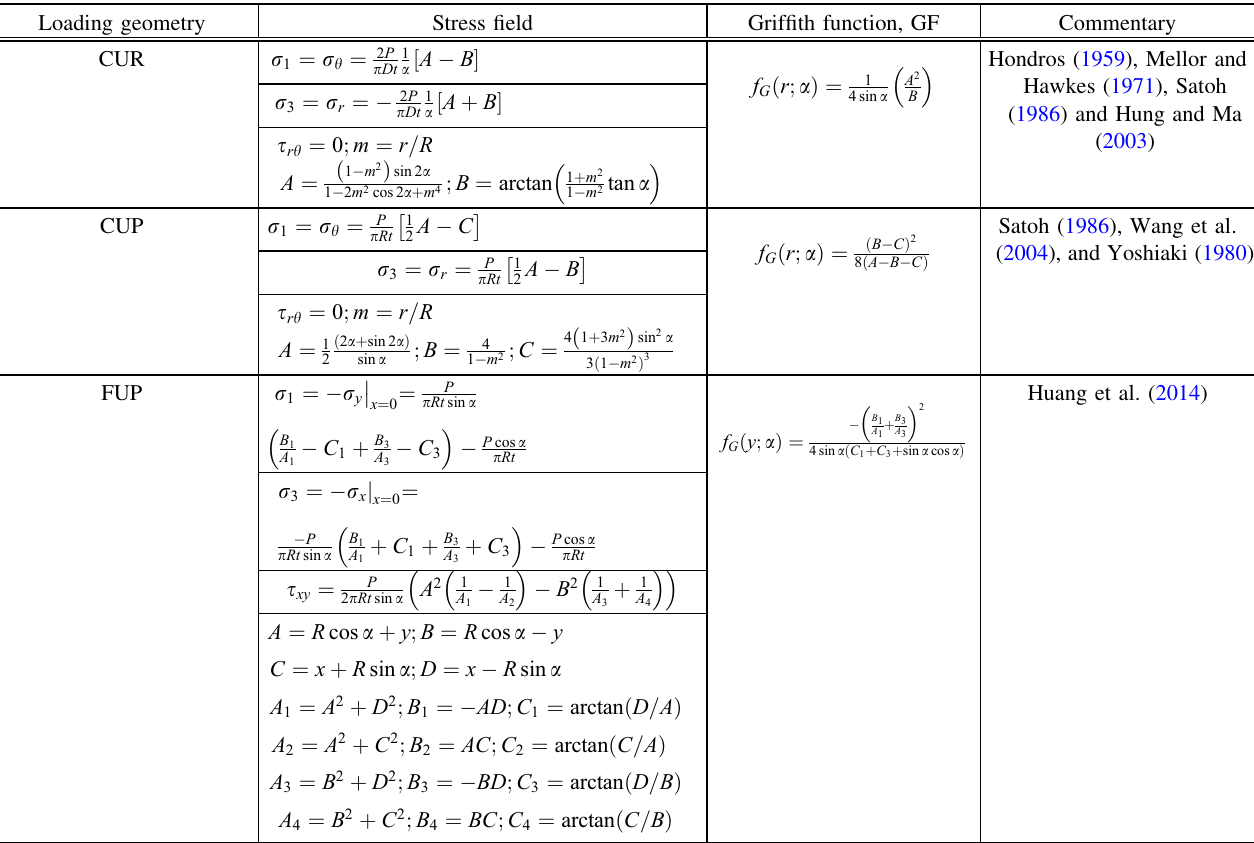
Table 2 Main stresses and Grif fi th function for the three loading geometries shown in Table 1. Loading geometry Stress field Griffith function,